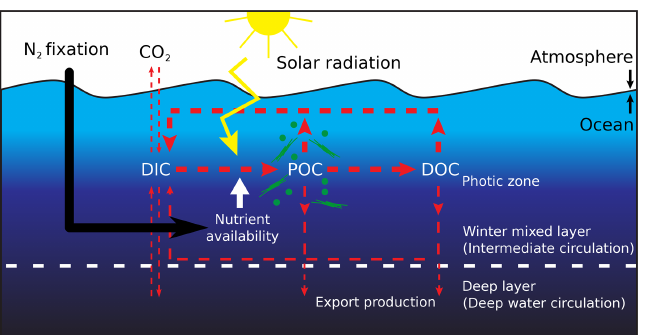
Figure 2. Major C fluxes of the biological carbon pump and main role of N 2 fixation. DIC: dissolved inorganic C; POC: particulate organic C; DOC: dissolved organic